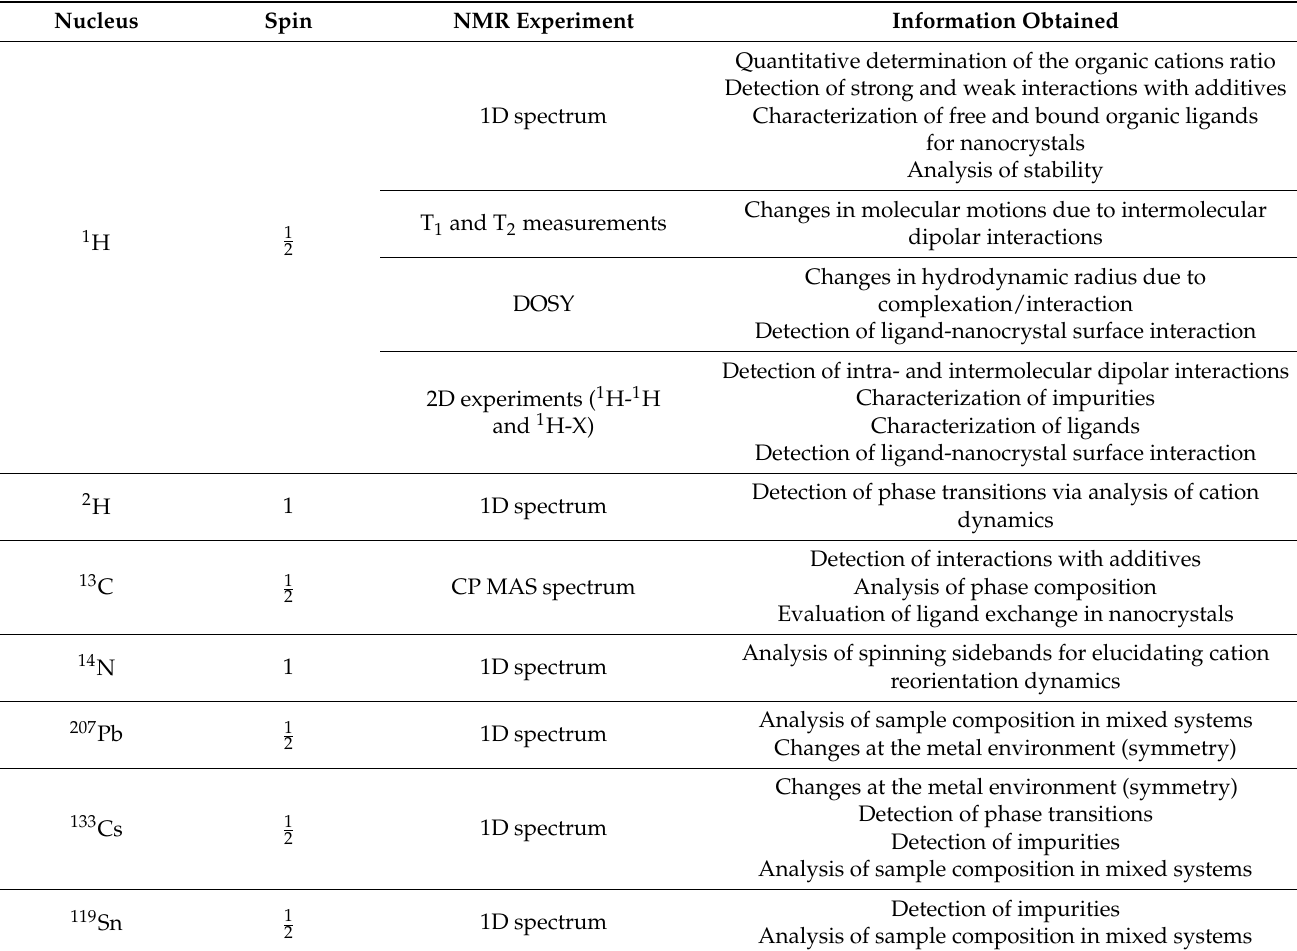
Table 1. List of NMR active nuclei exploited for perovskite